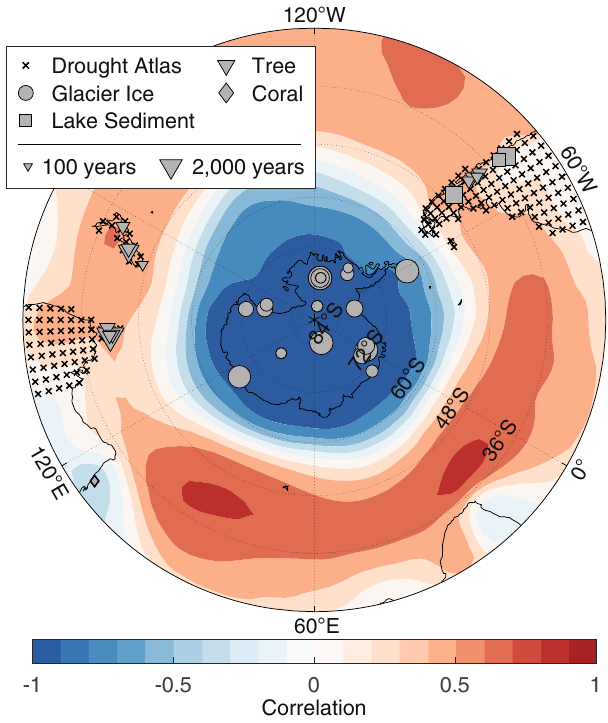
Fig. 1 | Proxy network map. Black Xs indicate the centroid of binned drought atlassites.GraymarkersindicatePAGES2ksites.ThesizeofthePAGES2kmarkers correspond to the length of each record. Filled color contours show the fi eld correlation between the Southern Annular Mode index and austral summer (December – February) mean sea level pressure from the 20th Century Reanalysis 117,118 over the period 1958-2000